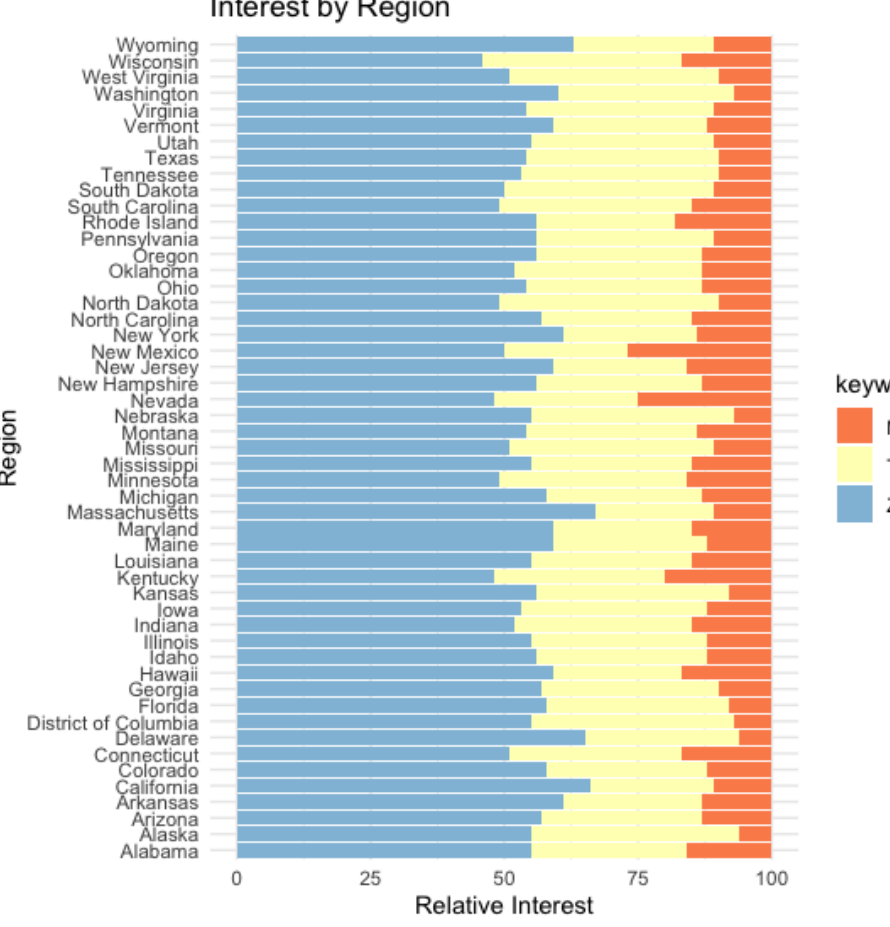
Figure 6. Analysis of the interest by region in the US for the top three SaaS programs (2017–2022). Created with the ggplot2 package in R environment with GT data sourced with the gtrendsR package.